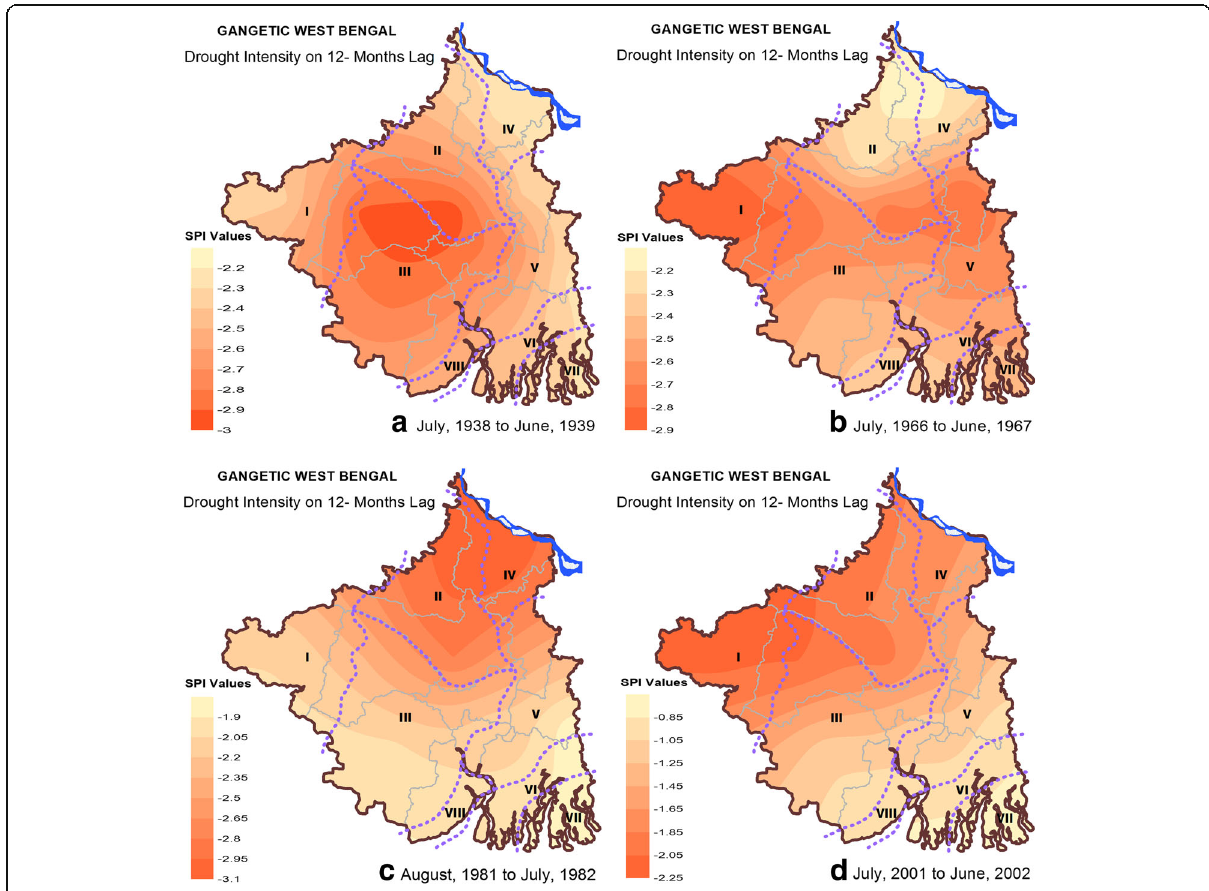
Fig. 6 Spatial variation of the draught intensity on 12- months lag for the year ( a ) 1983-39; ( b ) 1966-67; ( c ) 1981-82 and ( d ) 2001-02